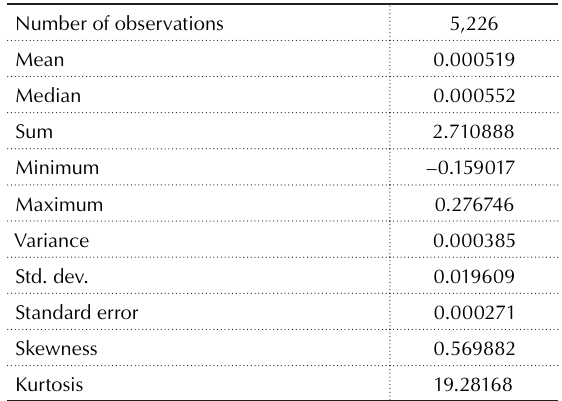
Table 1. Descriptive statistics for the PFST